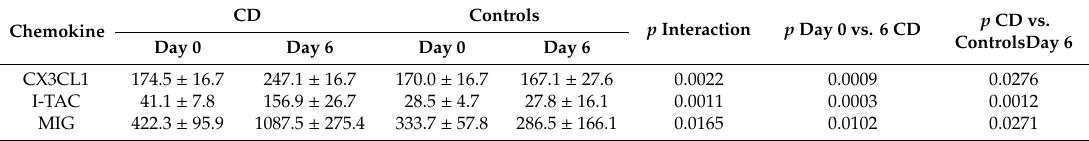
Table 2. Comparison of soluble protein levels (mean ± SE) in sera of CD patients and controls enrolled in a 3-day gluten challenge. Non-significant values are not